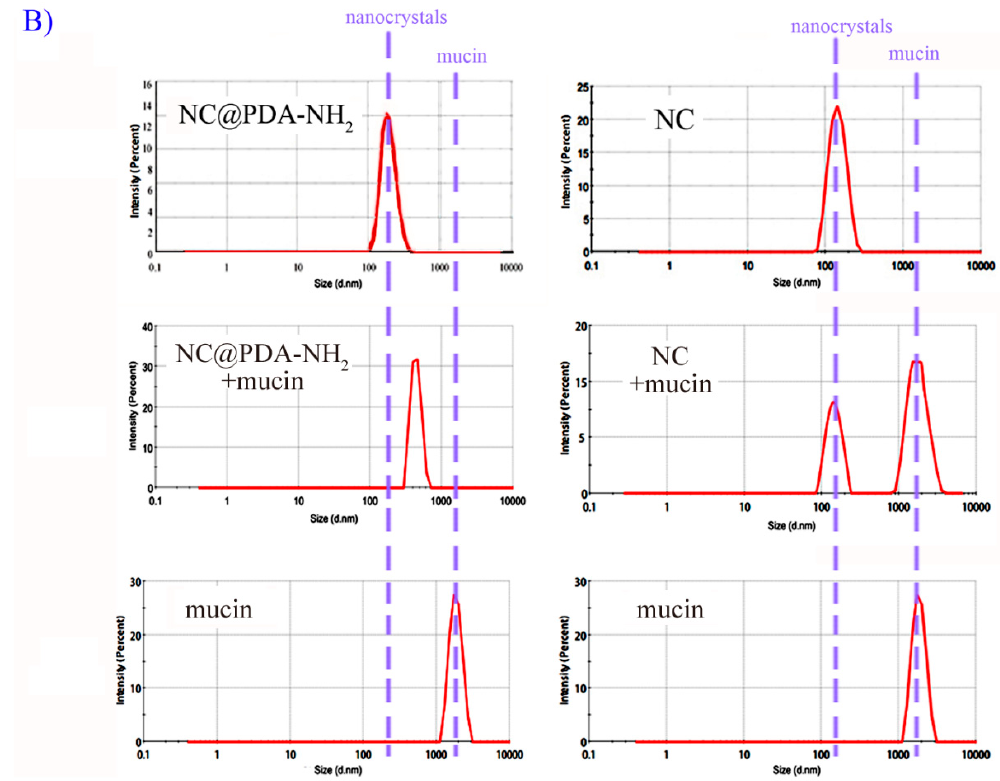
Figure 2. Interaction between NC@PDA-NH 2 and mucin. ( A ) Adsorption of mucin by NC@PDA-NH 2 with different surface charges or NC ( n = 3, mean ± SD). ( B ) Change in size distribution of NC@PDA ‐ NH 2 (or NC) after mixing with mucin. *** indicates p < 0.001.